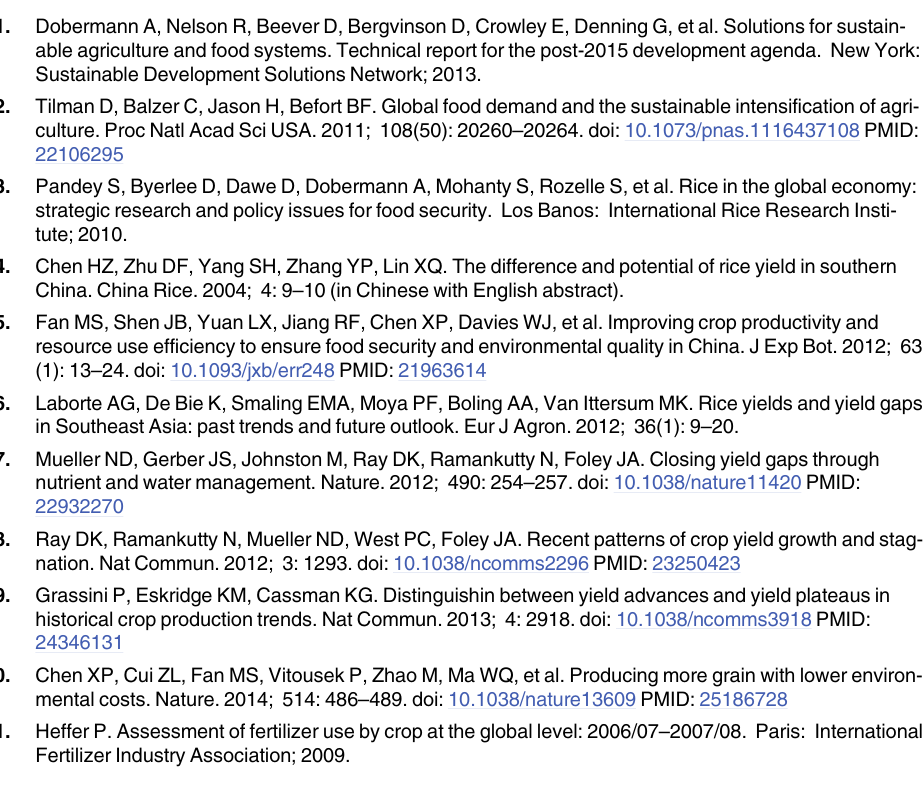
S1 Table. Total rice production, fertilizer N consumption and global warming potential (GWP) of N O and CH following different strategies for early and late rice in south China 2 4 and single rice in the Yangtze